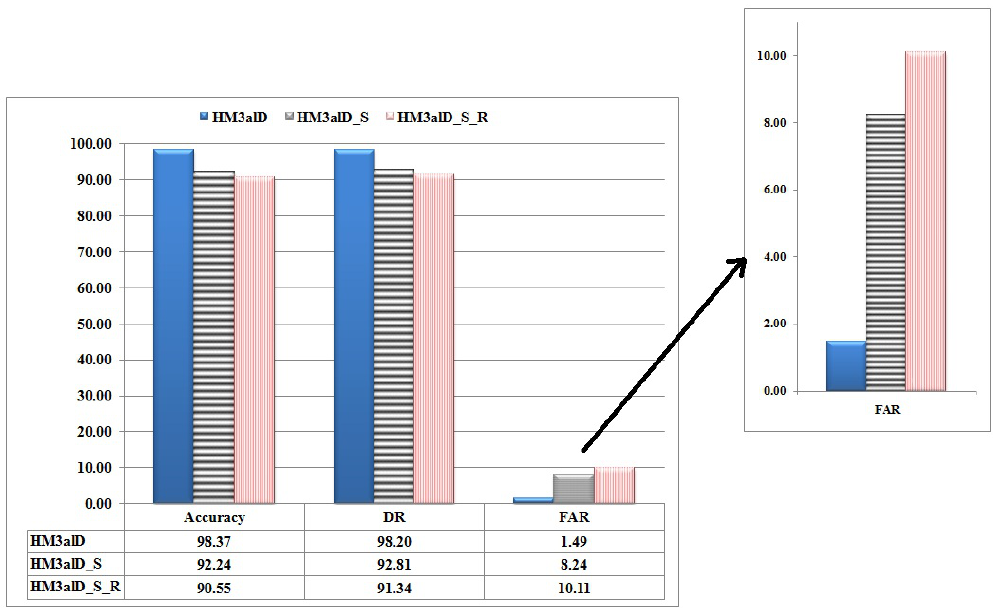
Figure 9. The performance comparison of HM 3 alD (for k = 24), HM 3 alD S (for k = 26) and HM 3 alD S R (for k =